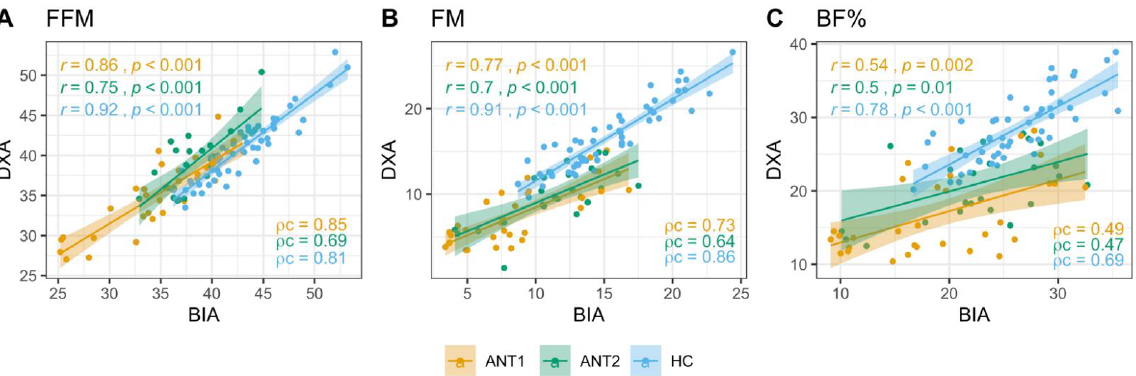
Figure 1. Correlation and concordance between DXA and BIA estimates of body composition. Strength of relation between DXA and BIA derived FFM ( A ), FM ( B ), and BF% ( C ) in ANT1, ANT2, and HC was assessed using the Pearson’s and Lin’s concordance correlation coefficients. r : Pearson’s correlation coefficients, p : p values, ρ c: Lin’s concordance correlation coefficient. FFM: Fat-free mass, FM: Fat mass, BF%: Body fat percentage.